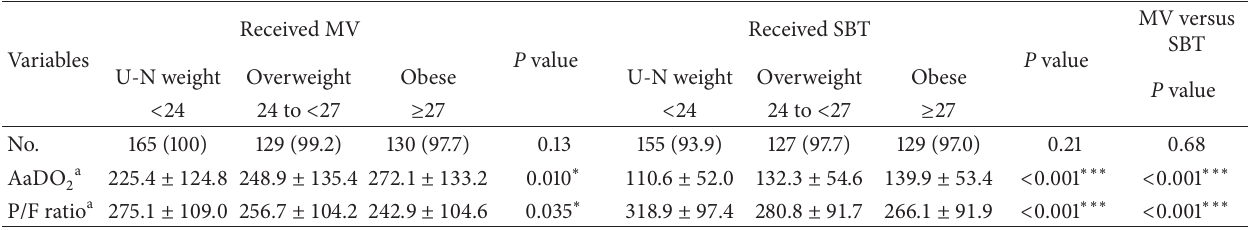
Table 2: Comparison of the arterial oxygenation levels of the MV and the SBT phases in the BMI groups.